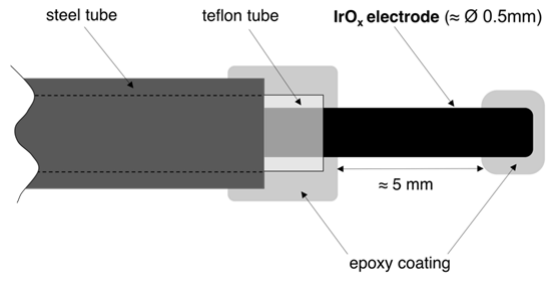
Figure 1. Schematic representation of IrO x sensors embedded in mortar. The pH sensitive part (IrO x electrode) is mounted in a stainless steel tube (outer diameter approx. 2 mm) to enable accurate positioning in the mortar/concrete. A Teflon tube electrically separates the steel and the IrO x . The ends are coated with an epoxy resin for sealing